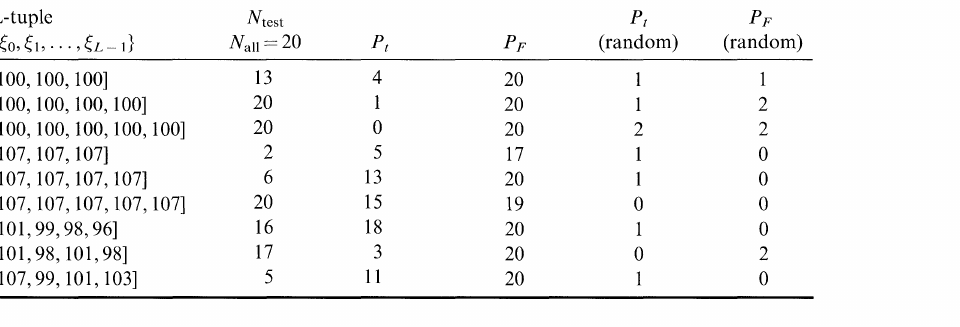
TABLE II Results of t-tests and F-tests applied to selected subseries. Ntest is the same as in Table I. Pt is the number of subseries selected by scaling indices for which the hypothesis of no mean shift is rejected (t-test, two-sided, c 0.05). PF is the number of subseries selected by scaling indices for which the hypothesis of no variance change is rejected (:F-test, two-sided, c --0.05). Pt (random) and PF (random) denote the corresponding numbers for randomly selected subseries L-tuple